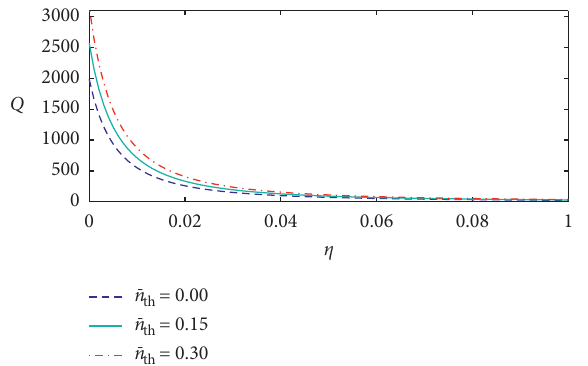
Figure 15: Plots of Mandel’s Q -factor (equation (39)) versus η for A � 100, κ � 0 . 8, ε � 0 . 399 and for different values of n